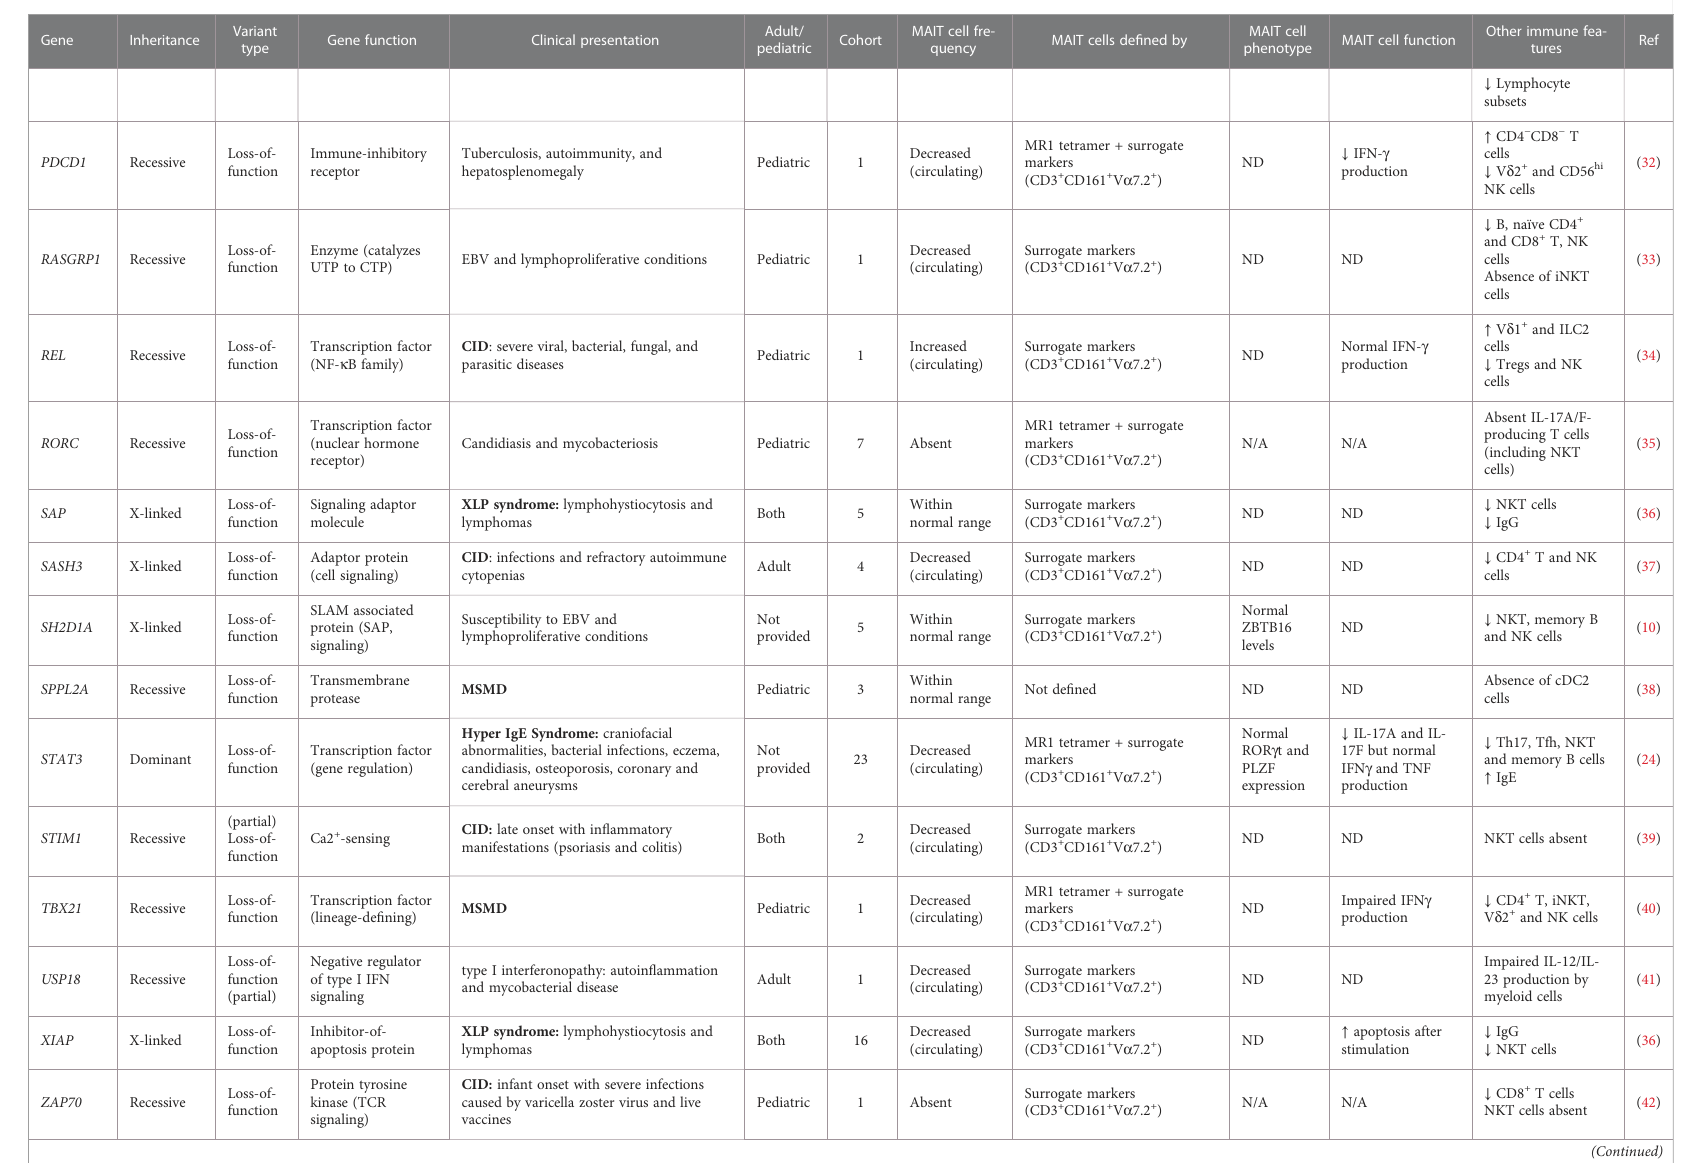
ZAP70 Recessive Loss-of- function